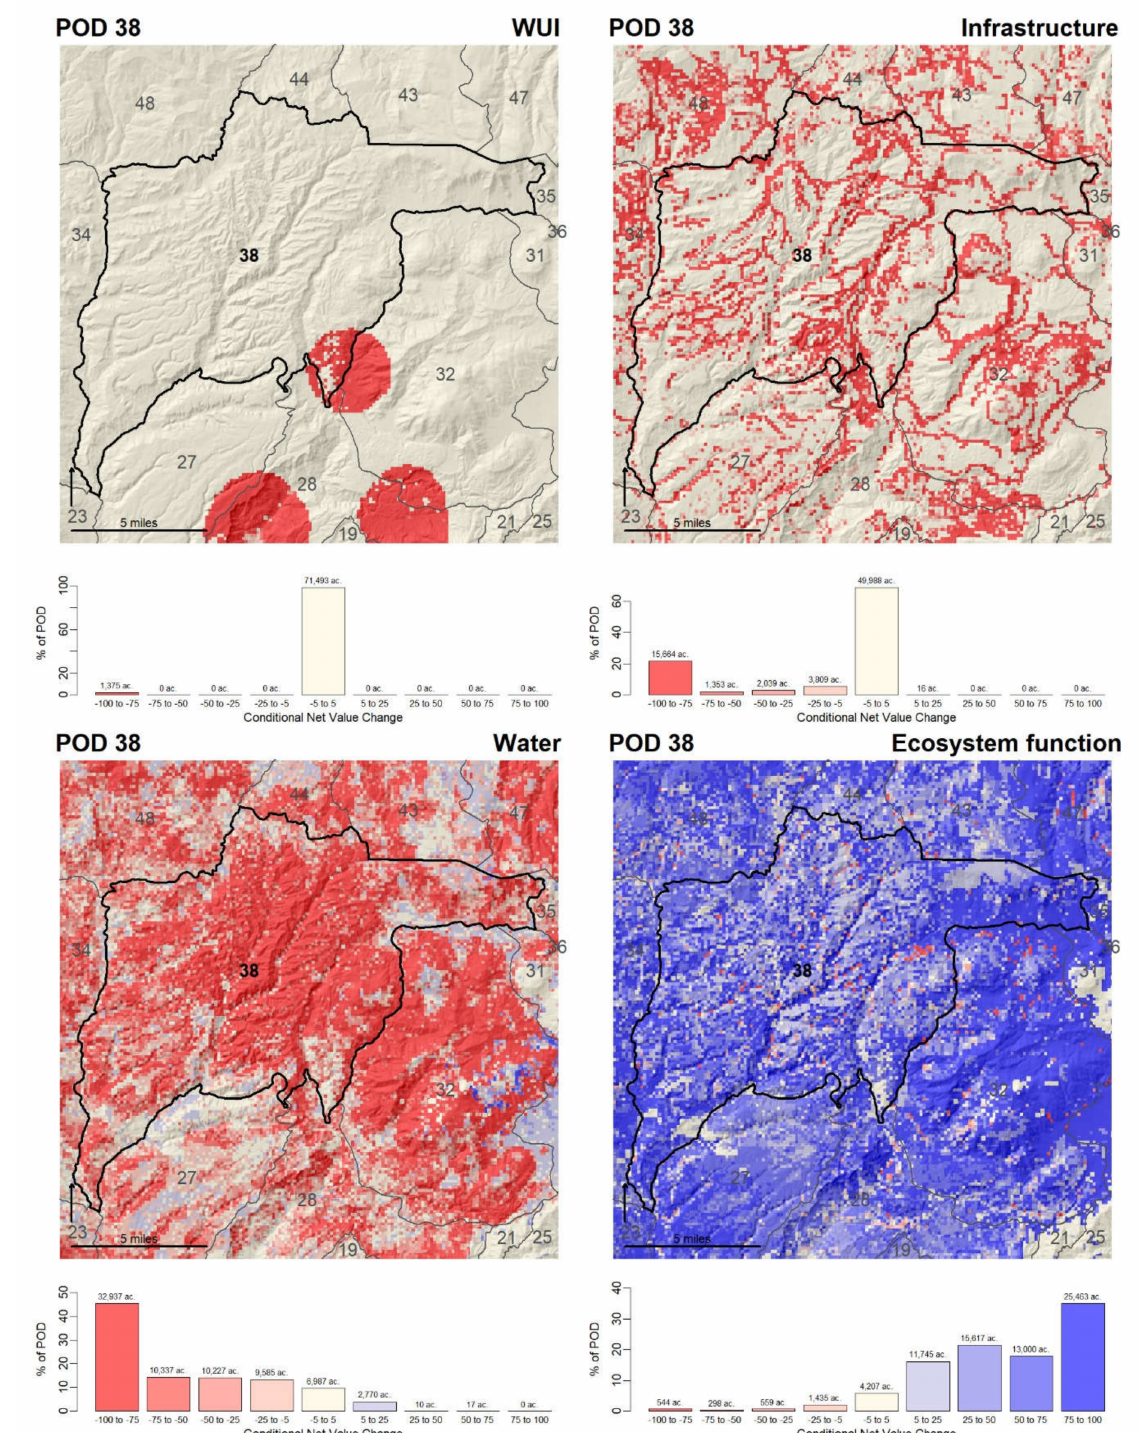
Figure 10. Spatial risk assessment results for POD 38, for a select set of HVRAs: wildland–urban interface (top left); infrastructure (top right); water (bottom left); and ecosystem function (bottom